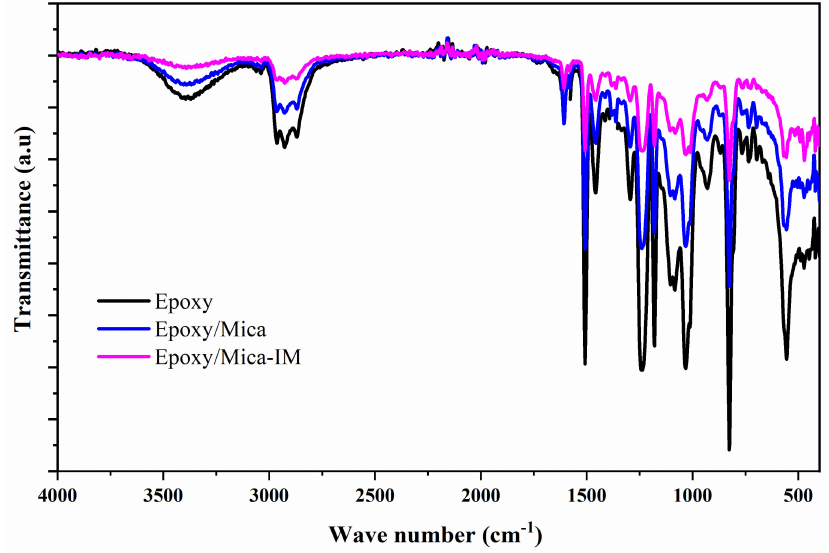
Figure 5. FTIR spectra obtained for the studied samples, blank epoxy and epoxy containing 0.1 wt % Mica or